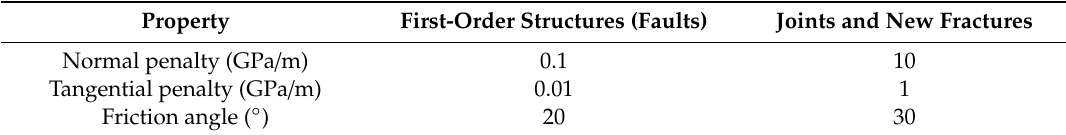
Table 2. Discontinuity parameters assumed for FDEM numerical modelling of the 2014 San Leo landslide in Elfen.